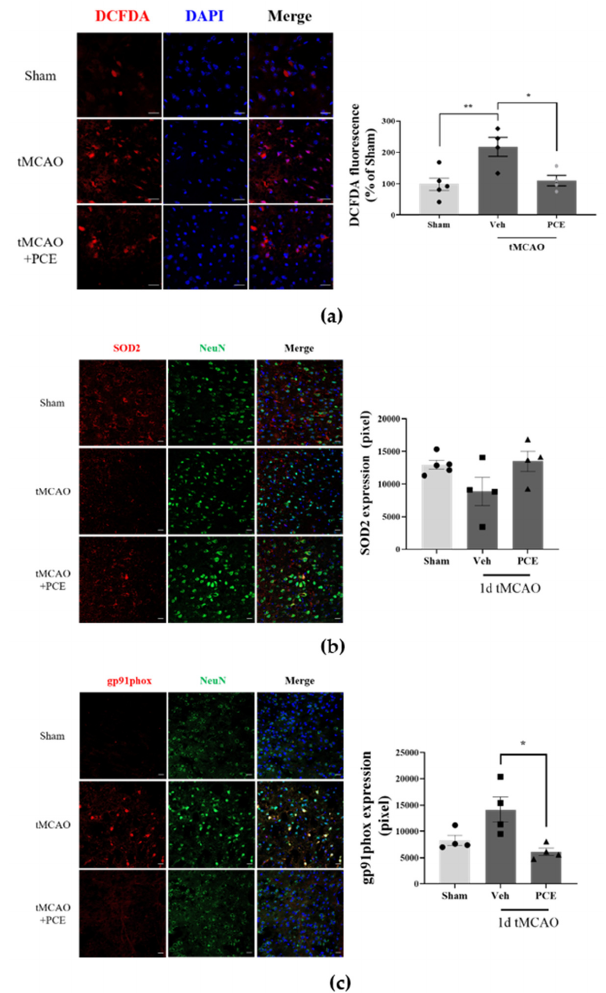
Figure 4. Antioxidant effects of PCE in the ischemic brain. Representative images of mouse brain stained with DCFDA, SOD2, and gp91phox. ( a ) DCFDA fluorescence was assessed along with the LDH assay following 2 h OGD and 0.5 h reoxygenation. PCE significantly decreased OGD-induced neurotoxicity. ( b ) The expression of SOD2 was decreased in the ischemic area after tMCAO, while PCE rescued its expression compared with the vehicle-treated tMCAO. ( c ) The expression of gp91phox was increased by ischemic stroke, whereas its expression in the PCE-treated tMCAO group was decreased compared with that in the vehicle-treated tMCAO group. The data represent mean ± SEM. White scale bar = 20 μ m. ** p < 0.01, * p < 0.05, analyzed using one-way ANOVA followed by the Tukey’s multiple comparison test (DCFDA, SOD2, n = 5; gp91phox, n = 4).